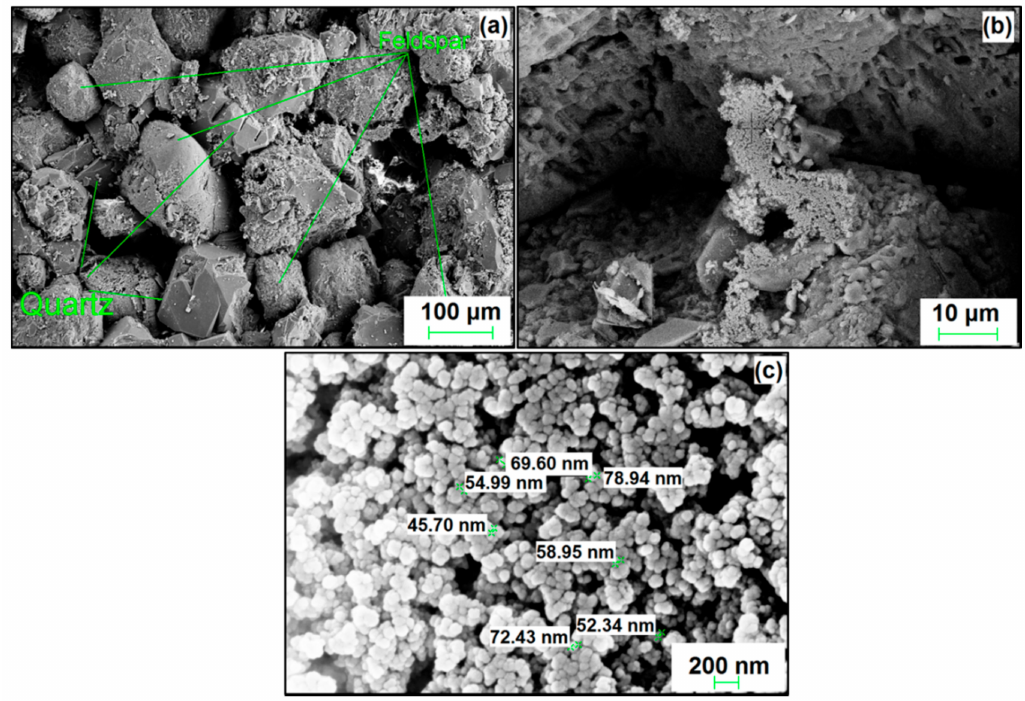
Figure 6. SEM image of ( a ) berea sandstone sample; ( b ) berea sandstone treated with nanofluid; ( c ) magnified look at the adsorbed/adhered